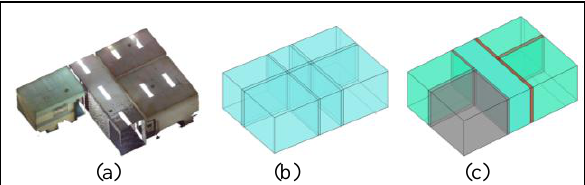
Figure 1. Subdividing an input point cloud (a) into navigable and non-navigable spaces represented by cuboid shapes (b) and merging them to form the final spaces (c). The brown, blue and grey cuboids represent walls, interior spaces and exteriors